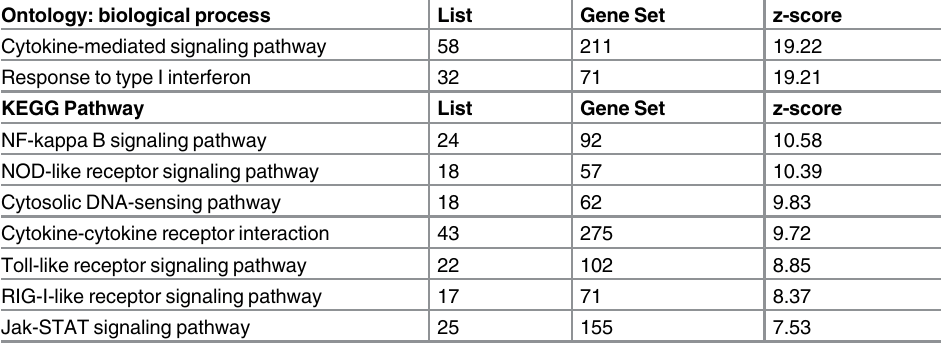
Table 2. Gene ontology and KEGG reports of up-regulated gene pathways. Ontology: biological